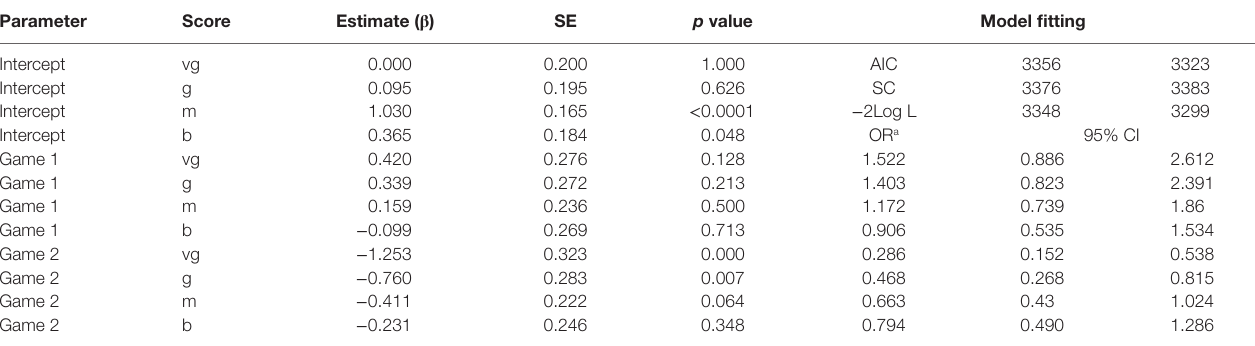
TABLe 10 | Results from multinomial logistic regression. a